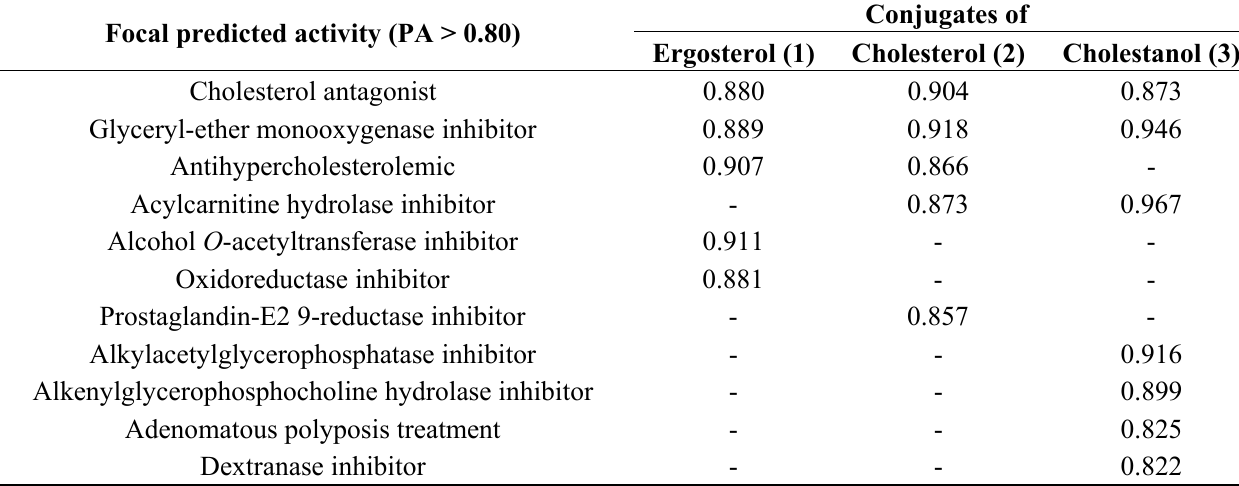
Table 1. Probability “to be Active” (PA) values for predicted biological activity of compounds 7 – 18